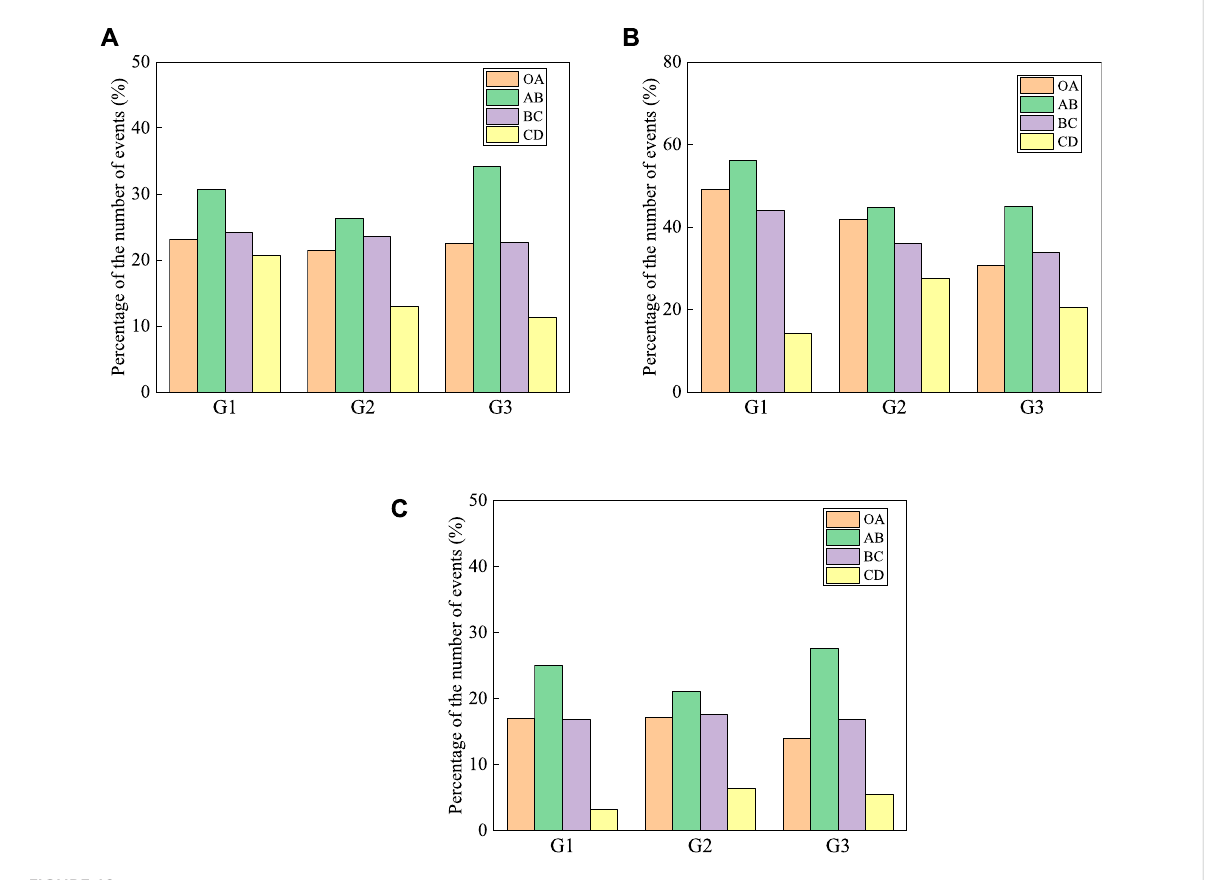
FIGURE 12 PercentagenumberofeventsinthedifferentstagesoftheCPDs: (A) 1,000 kHzinitialfrequencyevents, (B) 625 kHzpeakfrequencyevents,and (C) FEs at each stage.